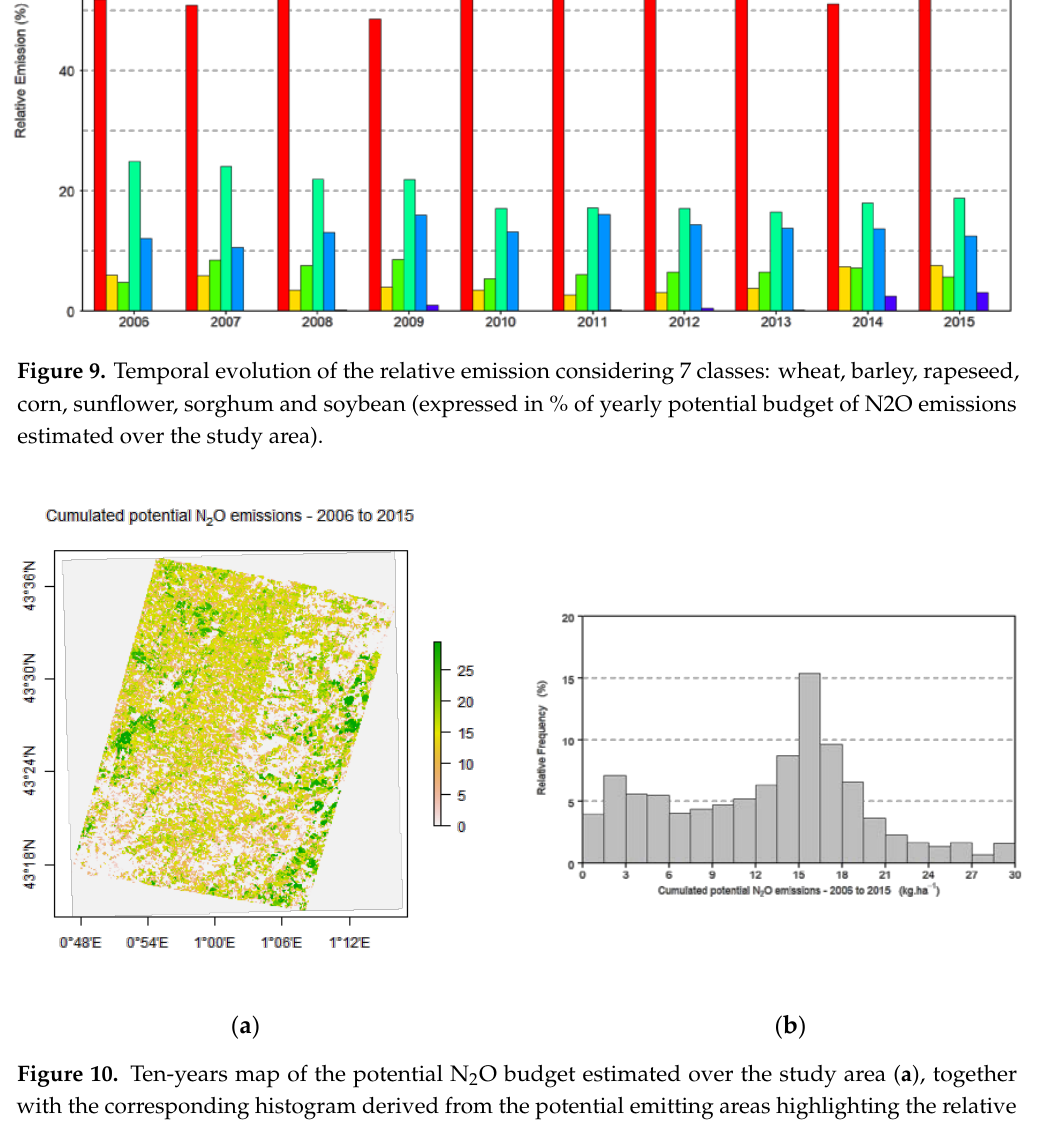
Figure 9. Temporal evolution of the relative emission considering 7 classes: wheat, barley, rapeseed, corn, sunflower, sorghum and soybean (expressed in % of yearly potential budget of N2O emissions estimated over the study area).